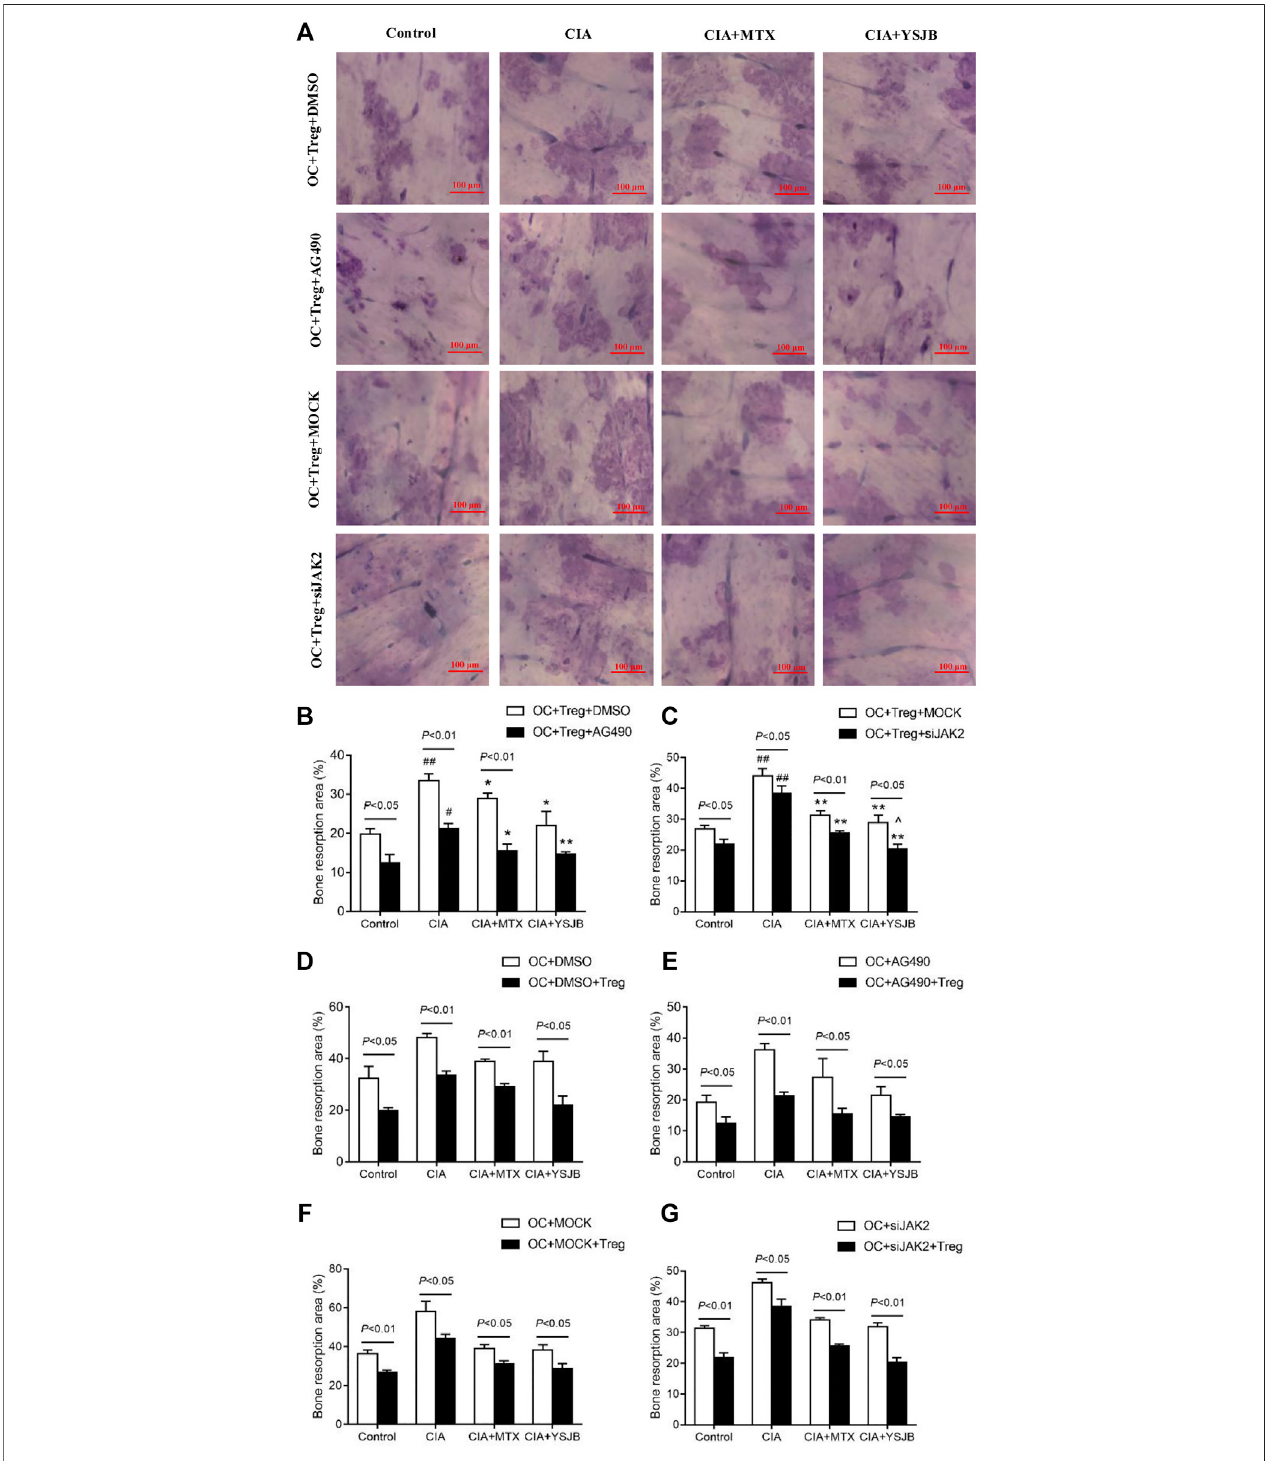
FIGURE6| EffectofYSJB,AG490andJAK2siRNAonboneresorptioninthecoculturesystem. (A) Imagesofboneresorptionpits.Scalebar (cid:2) 100 μ m. (B,C) The areas of the bone resorption pits were measured by the image analysis program. (D – G) The areas of the bone resorption pits after the addition of Tregs. The data are shown as the mean ± SEM (n ≥ 2). # p < 0.05, ## p < 0.01 compared with the control group; * p < 0.05, ** p < 0.01 compared with the CIA group; ^ p < 0.05, ^^ p < 0.01 compared with the CIA+MTX group.